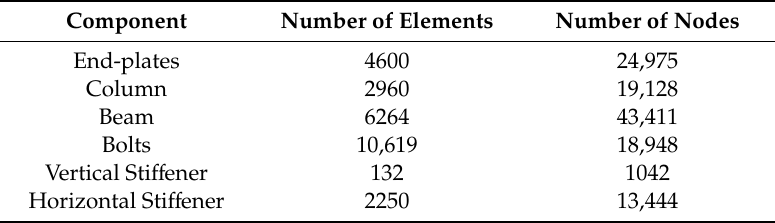
Table 5. Elements and nodes in numerical